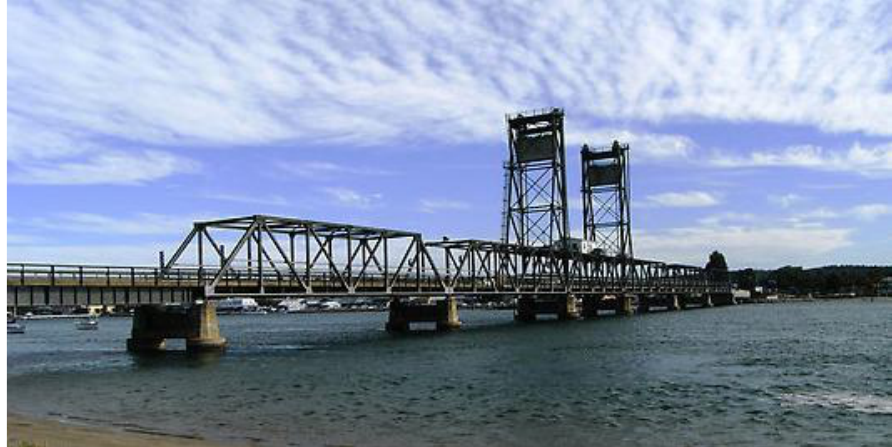
Figure 5. Bateman’s Bay Bridge (Photo: Taken by the Author).